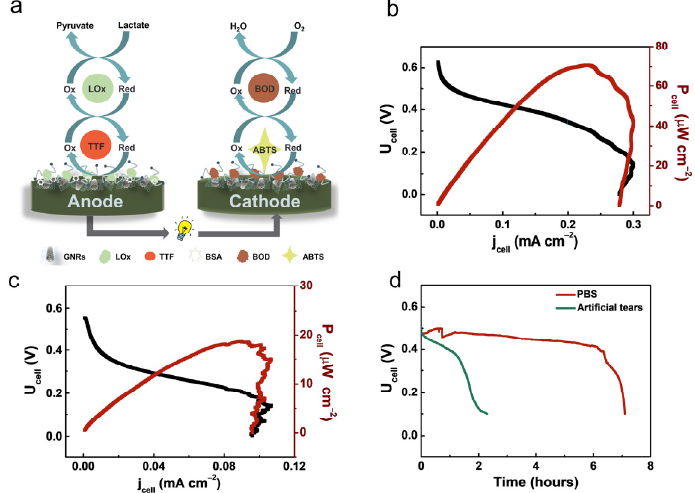
Figure 4. ( a ) Schematic diagram of the lactate/O 2 EBFC. LSV and power output curves of membrane- less lactate/O 2 EBFCs based on LOx-modified bioanode and BOD-modified biocathode in ( b ) 0.1 M PBS solution and ( c ) artificial tears (The red curve corresponds to the cell power density and the black curve corresponds to the cell voltage). ( d ) Galvanostatic discharge curves of the membrane-less lactate/O 2 EBFCs in 0.1 M PBS and artificial